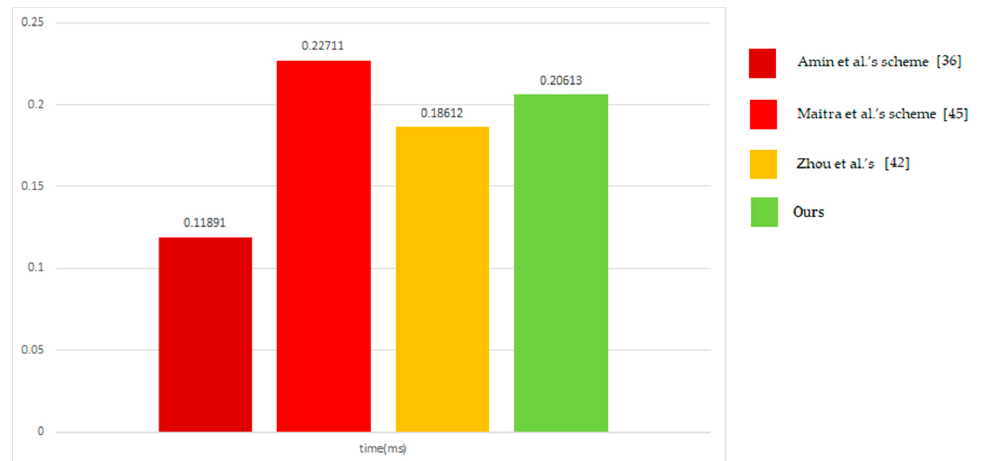
Figure 5. Comparison of total calculation cost (ms).